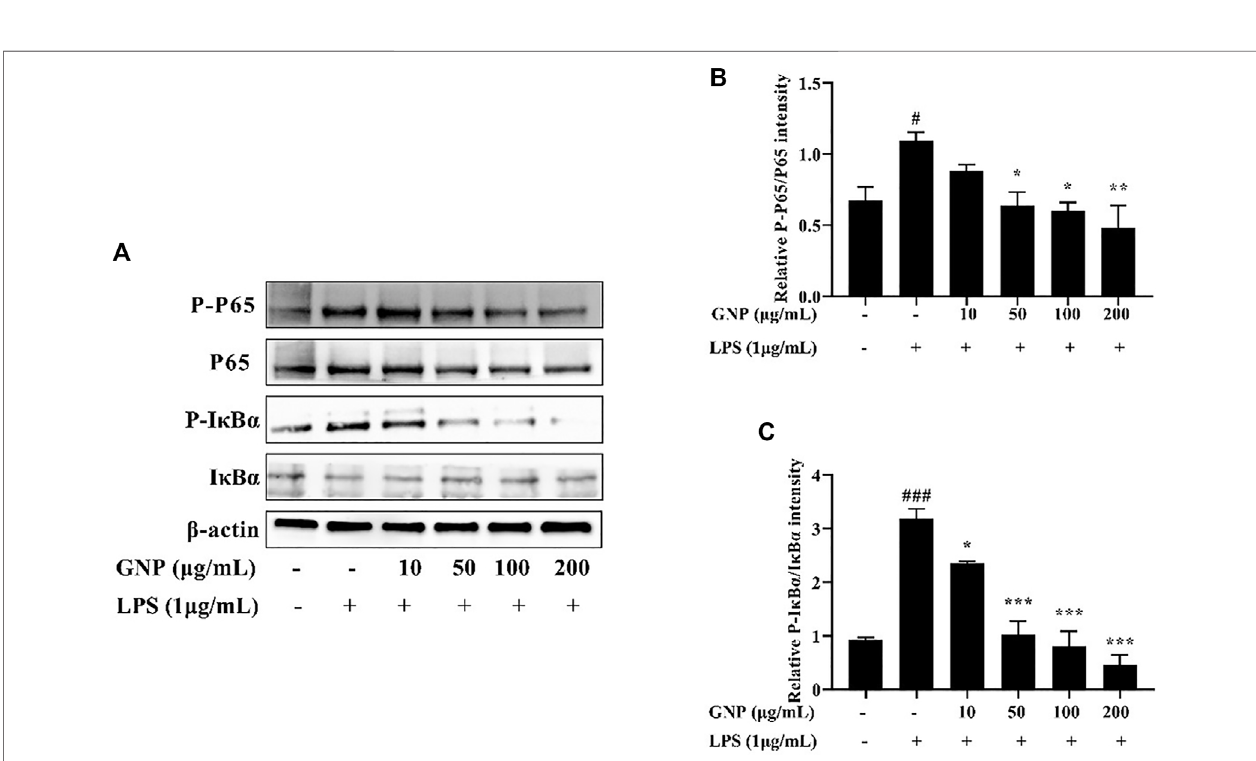
FIGURE 7 | Effect of GNP on the LPS-induced activation of the NF- κ B transcription factor in RAW 264.7 cells. (A) The phosphorylation levels of p65, p-p65, I κ B α , and p-I κ B α proteins in RAW 264.7 cells. Cells were treated with GNP (10, 50, 100, 200 μ g/ml) for 2 h and then treated with LPS (1 μ g/ml) for 24 h. (B) The ratios of p-p65/p65. (C) The ratios of p-I κ B α /I κ B α . Data are expressed as mean ± SD (n (cid:1) 3). (# indicates the signi fi cant difference between the LPS group and the blank group, # p < 0.05, ## p < 0.01, ### p < 0.001; * indicates a signi fi cant difference between the experimental group and the LPS group, * p < 0.05, ** p < 0.01, *** p < 0.001).